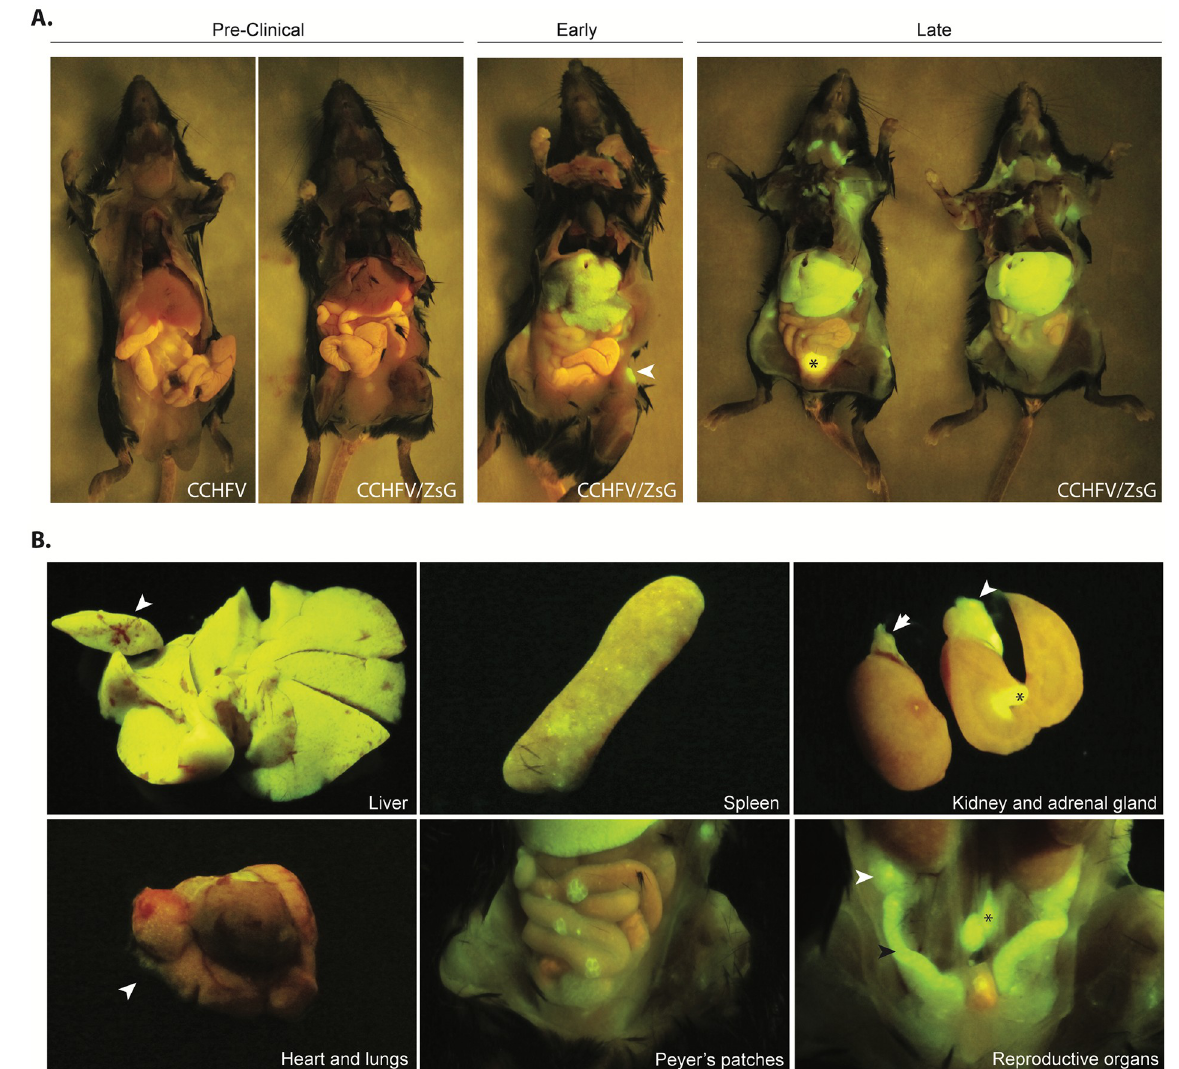
Fig 3. In situ visualization of CCHFV/ZsG infection. (A) No ZsG fluorescence was observed in pre-clinical CCHFV/ZsG-infected animals. A mouse infected with wild-type CCHFV is shown to demonstrate background autofluorescence levels when using the fluorescence detection setup; strong autofluorescence is seen in the bladder (due to urine content, see ✱ in right panel), and mild autofluorescence is observed in the intestinal tract. In early-stage CCHFV/ZsG infection, extensive ZsG fluorescence was detected in the livers and lymph nodes of the mice; white arrow head indicates inguinal lymph node. In late-stage CCHFV/ZsG infection, extensive ZsG fluorescence was observed in the liver and lymphoid organs (brachial, mediastinal, inguinal, and lumbar lymph nodes). A single representative animal from each clinical stage is shown; ZsG fluorescence levels in organs were similar between animals. (B) Organ-specific viral distribution patterns were observed in: liver (top left; white arrow represents a transverse cross section of one lobe of the liver); spleen (top middle); kidney and adrenal gland (top right, white arrow represents the adrenal gland, ✱ represents the renal pelvis demonstrating urine autofluorescence); heart and lung (bottom left; white arrow shows diffuse ZsG fluorescence in the lung); intestinal tract showing strong fluorescence in the Peyer’s patches (bottom middle); and reproductive tract (bottom right; white arrow, ovary; black arrow, uterus; ✱ , iliac lymph nodes).